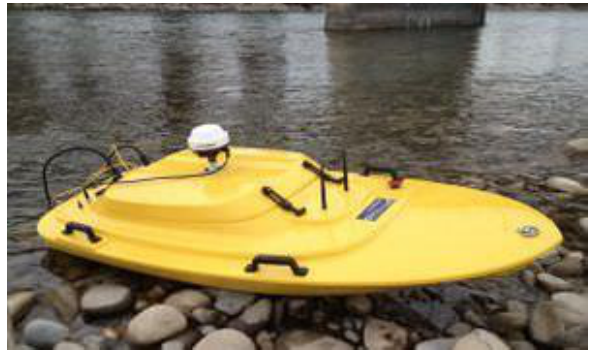
Figure 5 . Z-Boat 1800 (Teledyne, 2012)